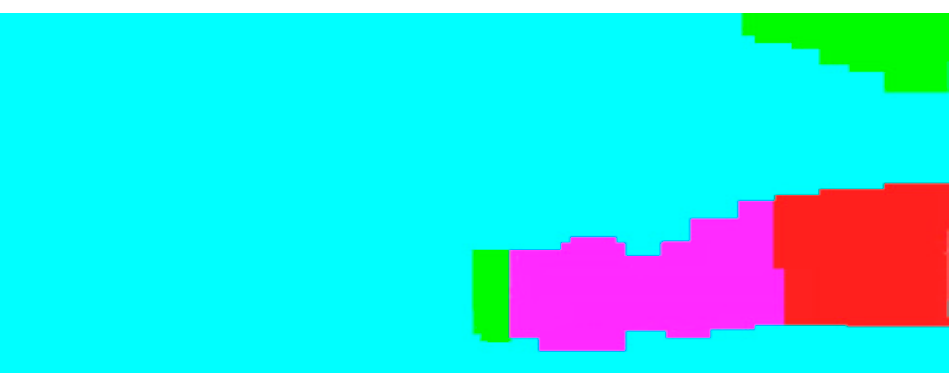
Figure 20. Wave length estimation distribution for sand waves.